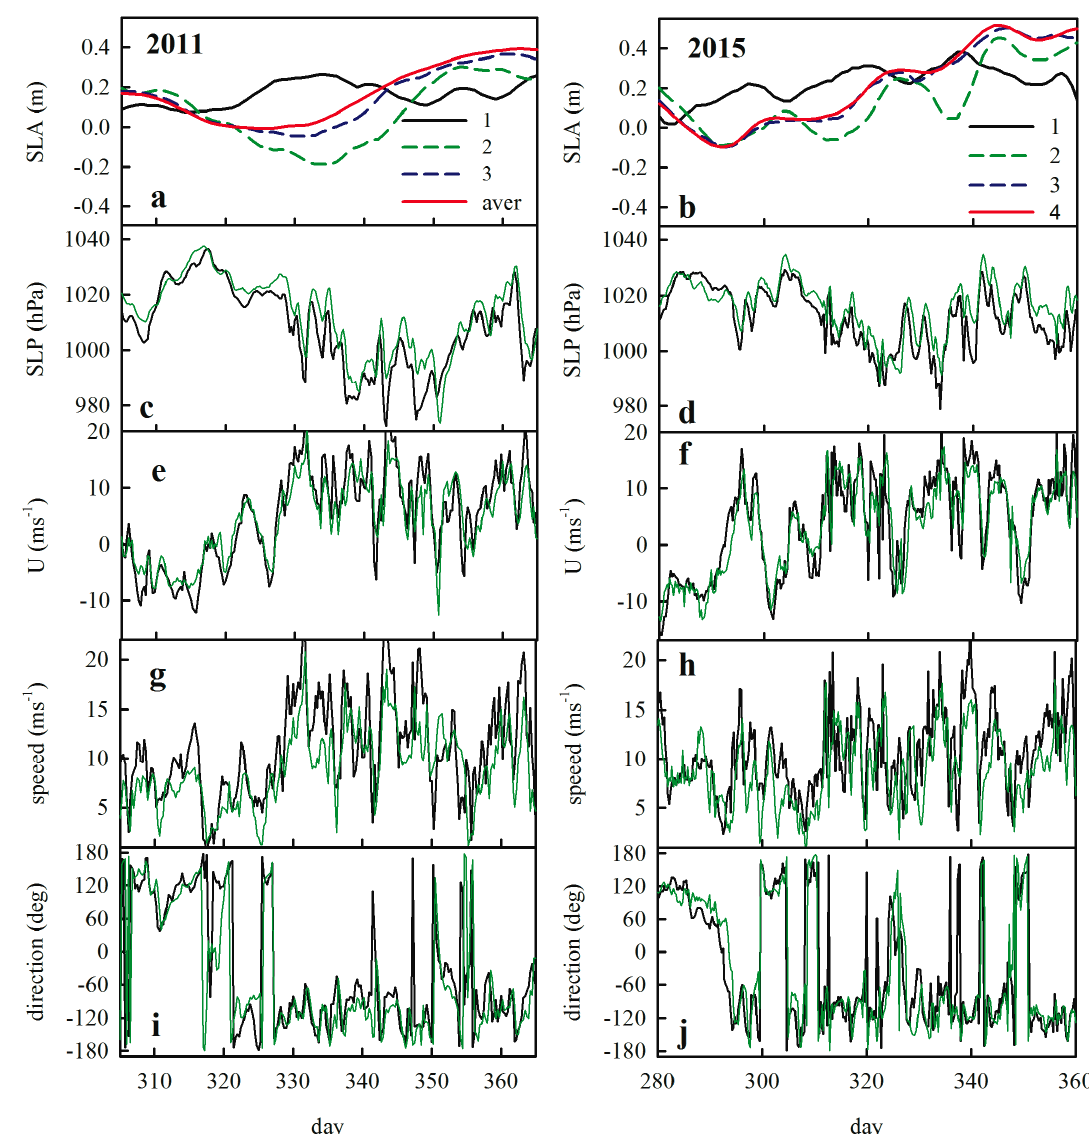
Figure 6. The same as in Figure 5, but data are presented for MBIs in 2011 (column on the left side) and 2015 (column on the right side).